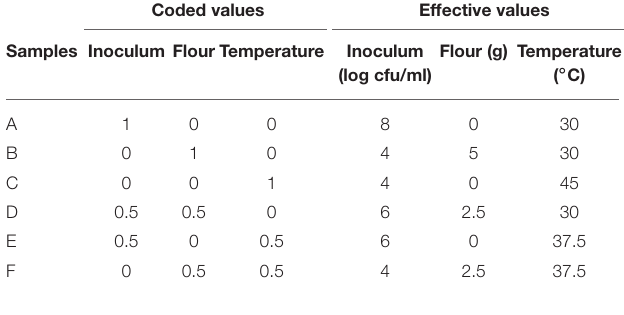
TABLE 1 | Combinations of the centroid. Coded values Effective values